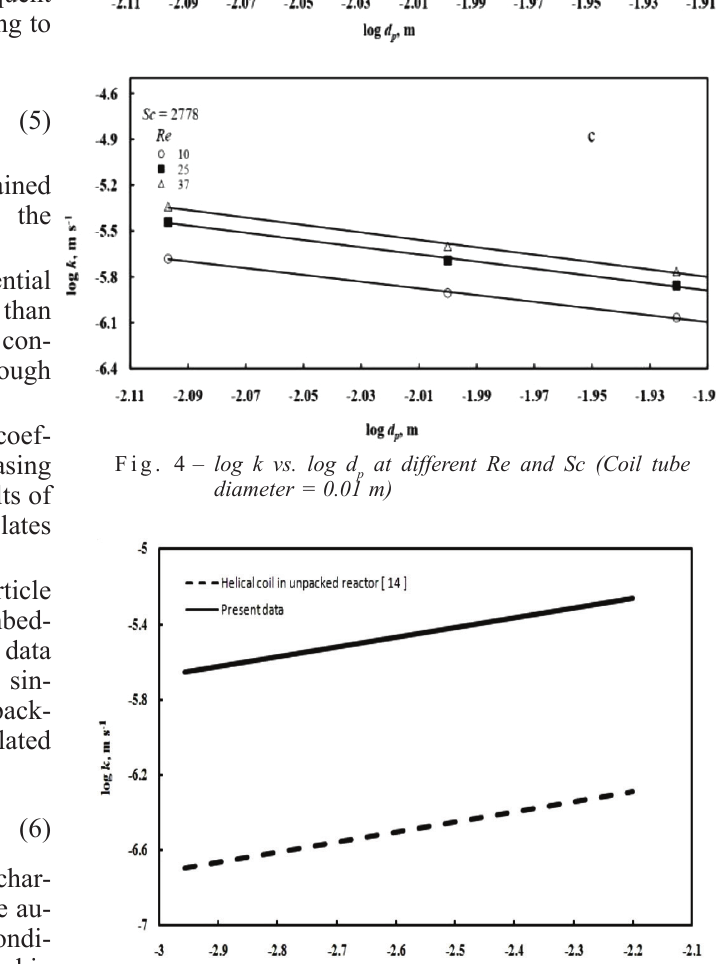
Fig. 5 – Comparison between the mass transfer behavior of a helical coil in a packed and unpacked reactor (coil tube di­ ameter = 0.016 m, packing cylinder diameter = 0.008 m, Sc =